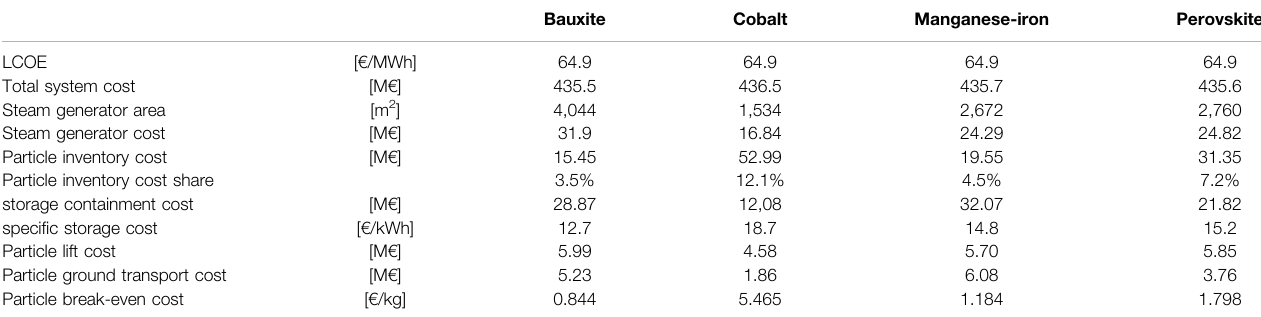
TABLE 2 | Cost contributions and the particle break-even cost of considered